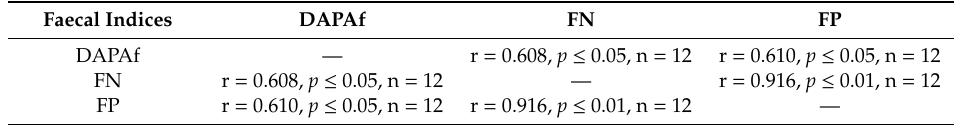
Table 4. Pearson correlation coefficient ( r, p -values) between faecal indices.